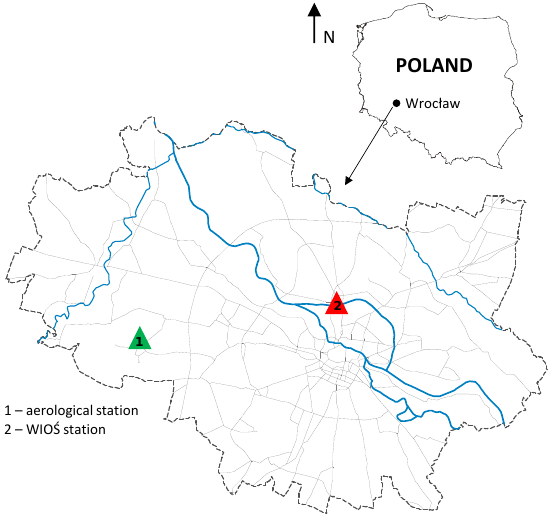
Figure 1. Location of the measuring stations in Wrocław (Poland).